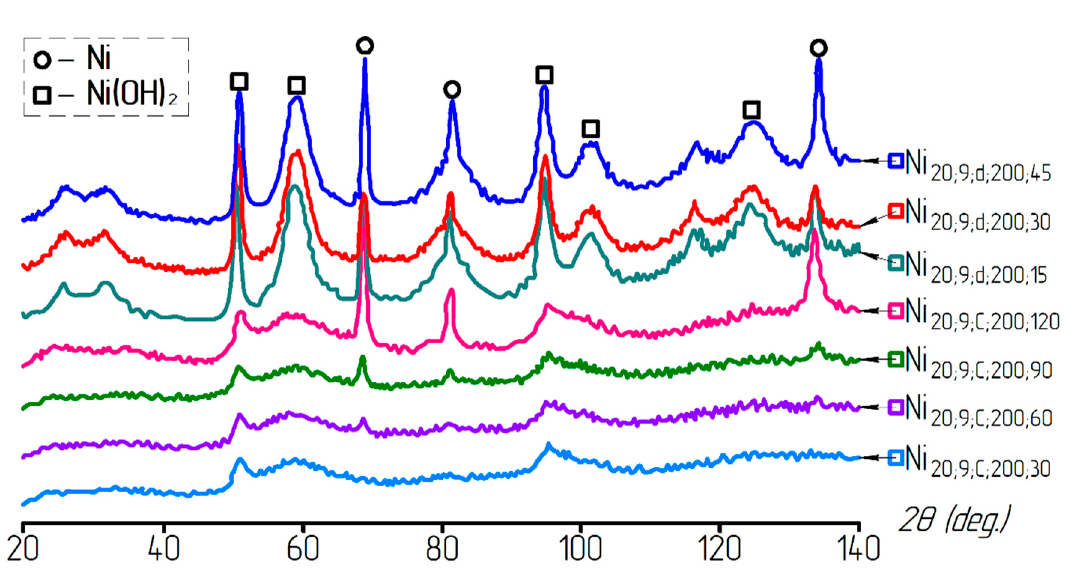
Figure 8. XRD patterns of the samples after reduction at a temperature of 200 °C.